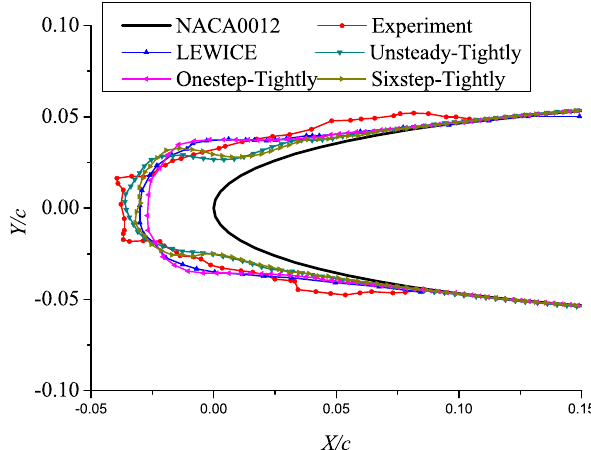
Figure 15. Comparison of ice